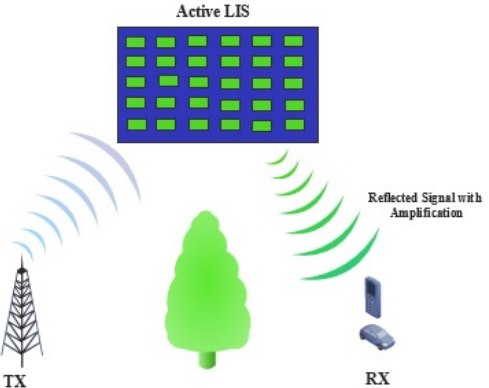
Figure 2. Block diagram of a LIS serving multiple users simultaneously.